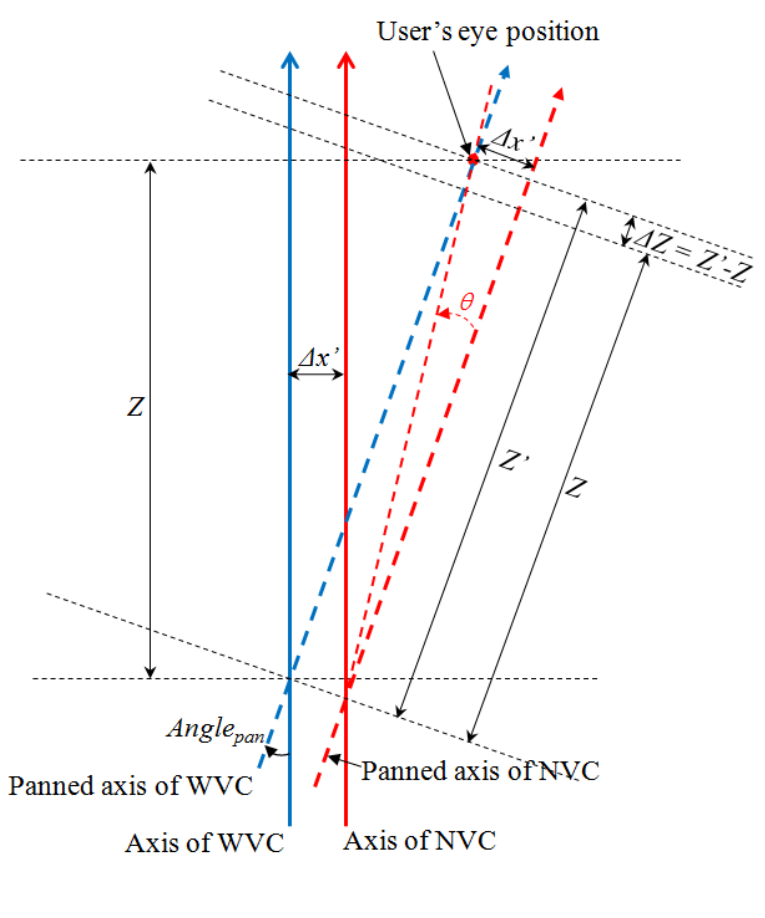
and Offset pan x